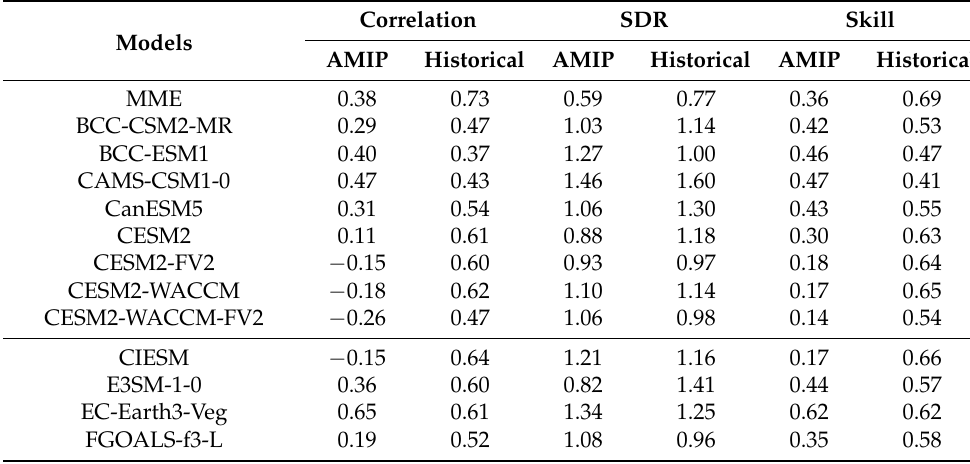
Table 4. Correlation coefficient, SDR and skills for vertical velocity at